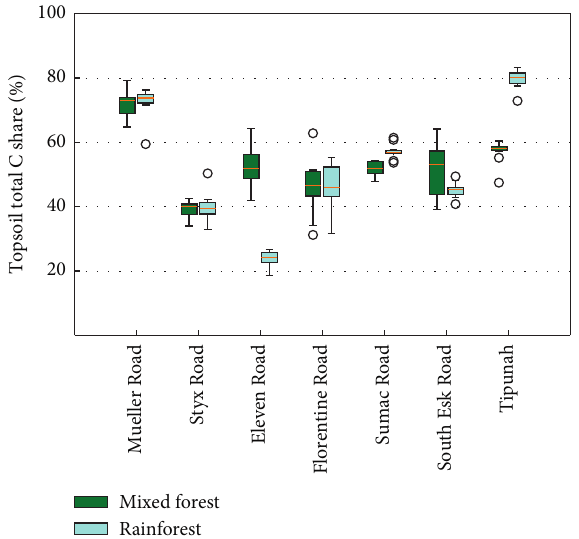
Figure 4: Proportion of total C held in topsoils (0–30cm depth). Green shading � mixed forest; blue shading � rainforest. The bars indicate 1.5x the interquartile range. Open circles indicate values outside this